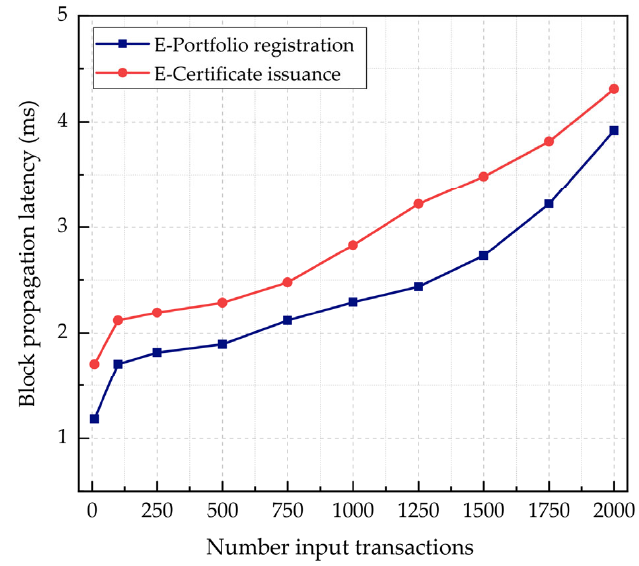
Figure 8. E ‐ portfolio registration and e ‐ certificate issuance transaction block latency measurements Figure 8. E-portfolio registration and e-certificate issuance transaction block latency measurements with variable input transaction rates. with variable input transaction